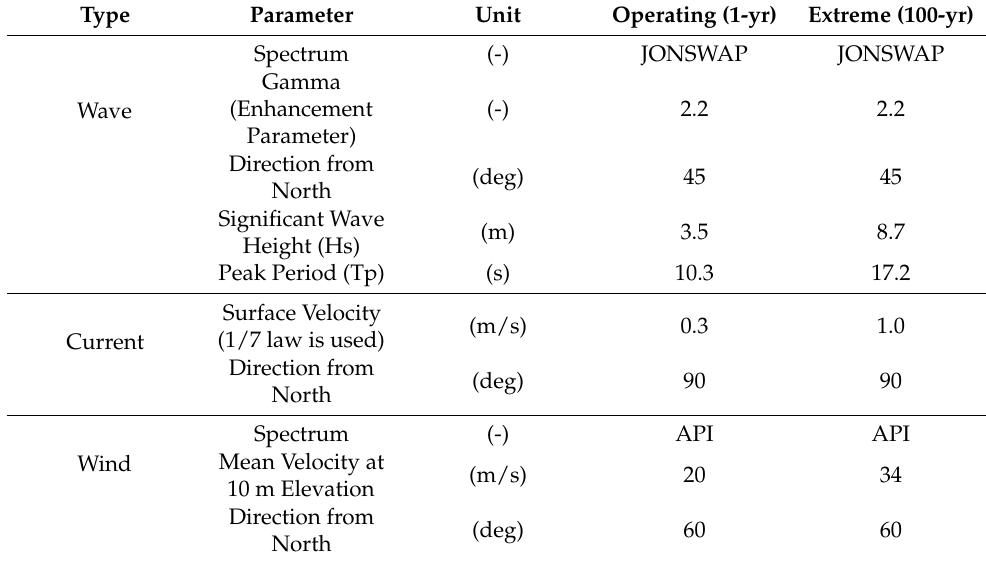
Figure 7. Comparison among Actual vs. Dual-Algorithm vs. Forced Top Oscillation of SCR and SLWR system, WD1000 (Arc Length = 1500 m). Table 3. Environmental Loading Consideration. Table 4. Environmental